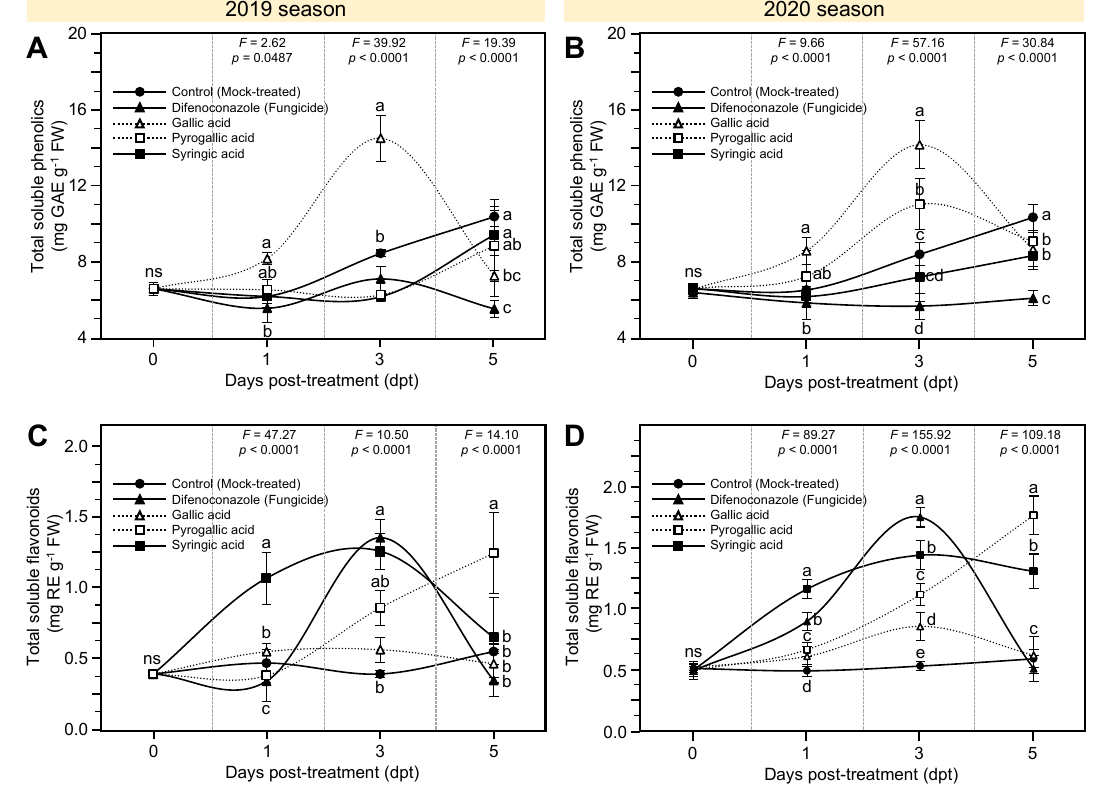
Figure 5. Effects of gallic acid and its derivatives on biochemical analysis of tomato plants (Super strain B–F 1 hybrid) infected with A. solani under greenhouse conditions ( n = 6). ( A , B ) Total soluble phenolics during 2019 and 2020 seasons, respectively; ( C , D ) total soluble flavonoids during 2019 and 2020 seasons, respectively. Values represent means of six replications, while whiskers reflect the standard deviation (Means ± SD). Different letters indicate statistically significant differences among treatments, while “ns” or the same letter signify no significant differences among treatments using the Tukey–Kramer honestly significant difference test (Tukey HSD; p < 0.05).